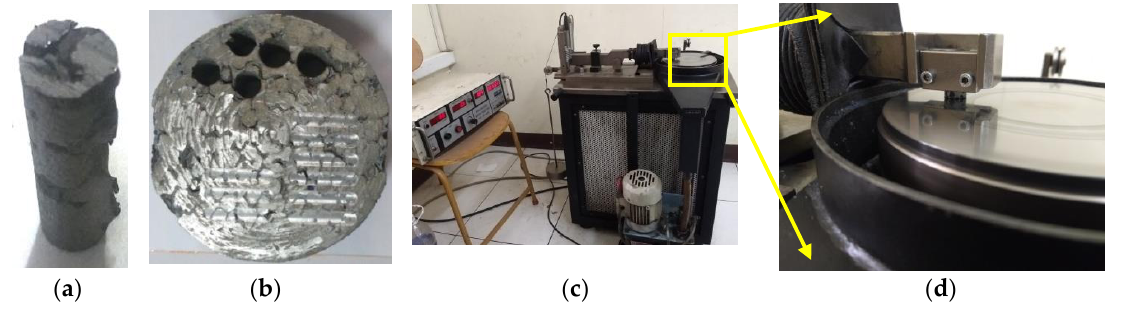
Figure 2. ( a ) The C4 wear test specimen extracted using abrasive water jet machine (AWJM); ( b ) the C4 composite after the AWJM process; ( c ) pin-on-disc tribometer; ( d ) the wear specimen mounted on the pin-on-disc machine.